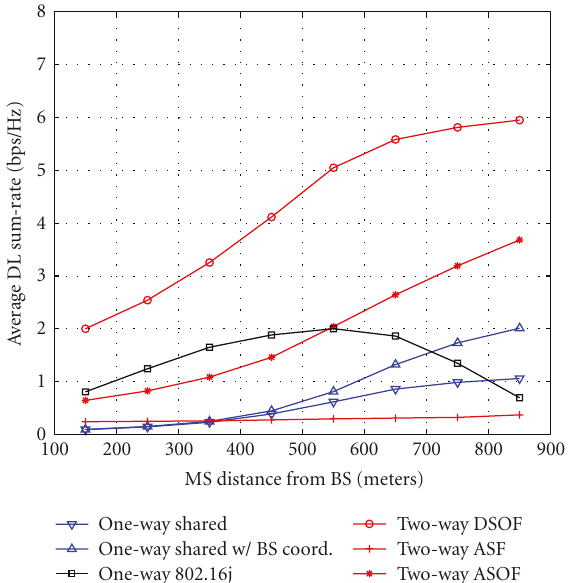
Figure 4: DL sum rate performances versus MS distance from BS.